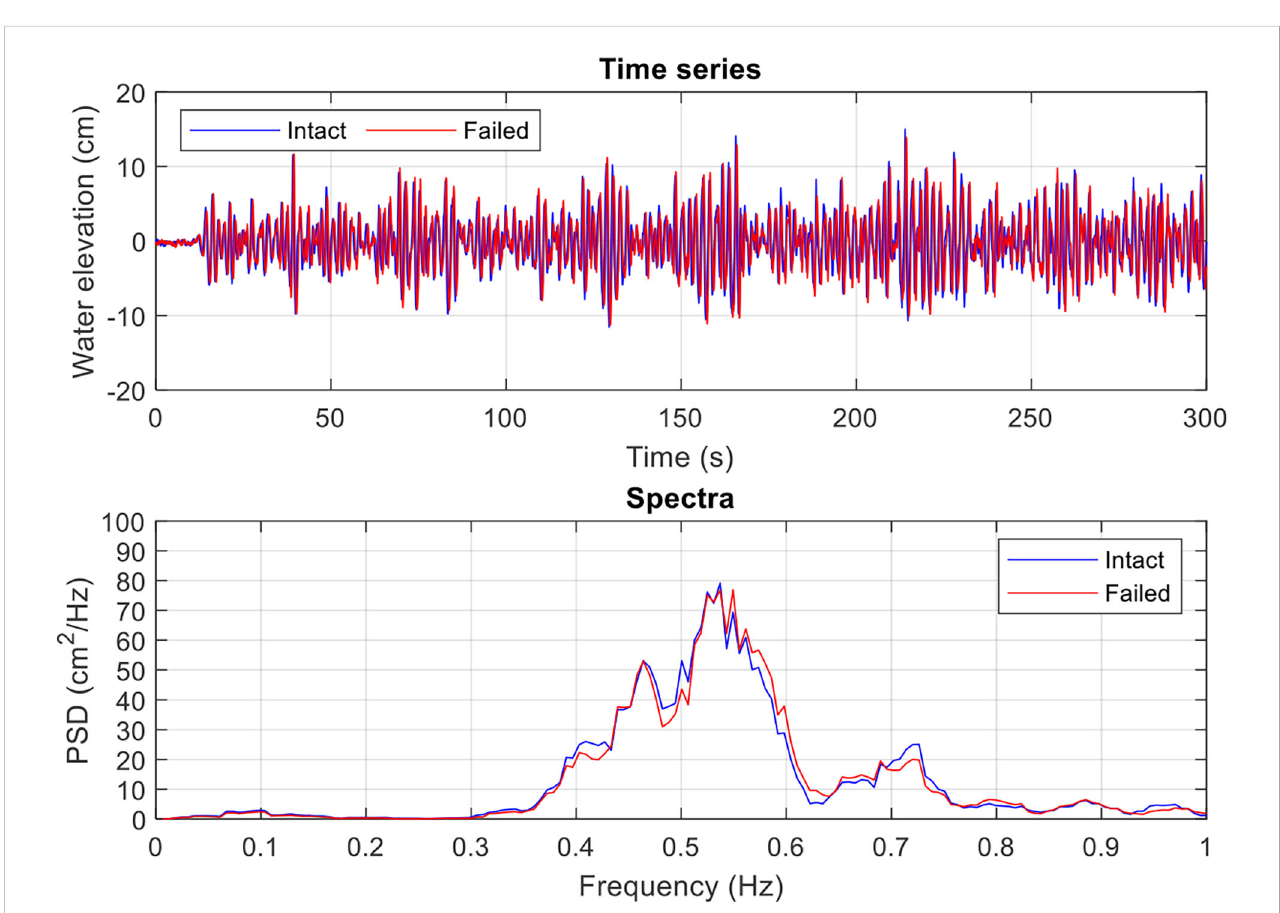
FIGURE 4 Time series and power spectral density of the incident